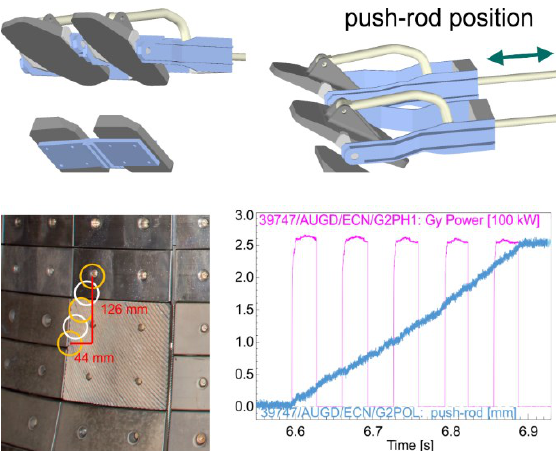
Fig. 9. Exemplary visualisation of the applied mm-wave power and timing of the launcher sweep. The inclination of the launcher mirror is controlled by the push-rod position (top). Five pulses are applied during one sweep of the launcher. The pulses end up on different positions on the heat shield and around one selected thermocouple of the corresponding reflecting grating (photo bottom left). The timing of the push- rod position and of the applied mm-wave power are